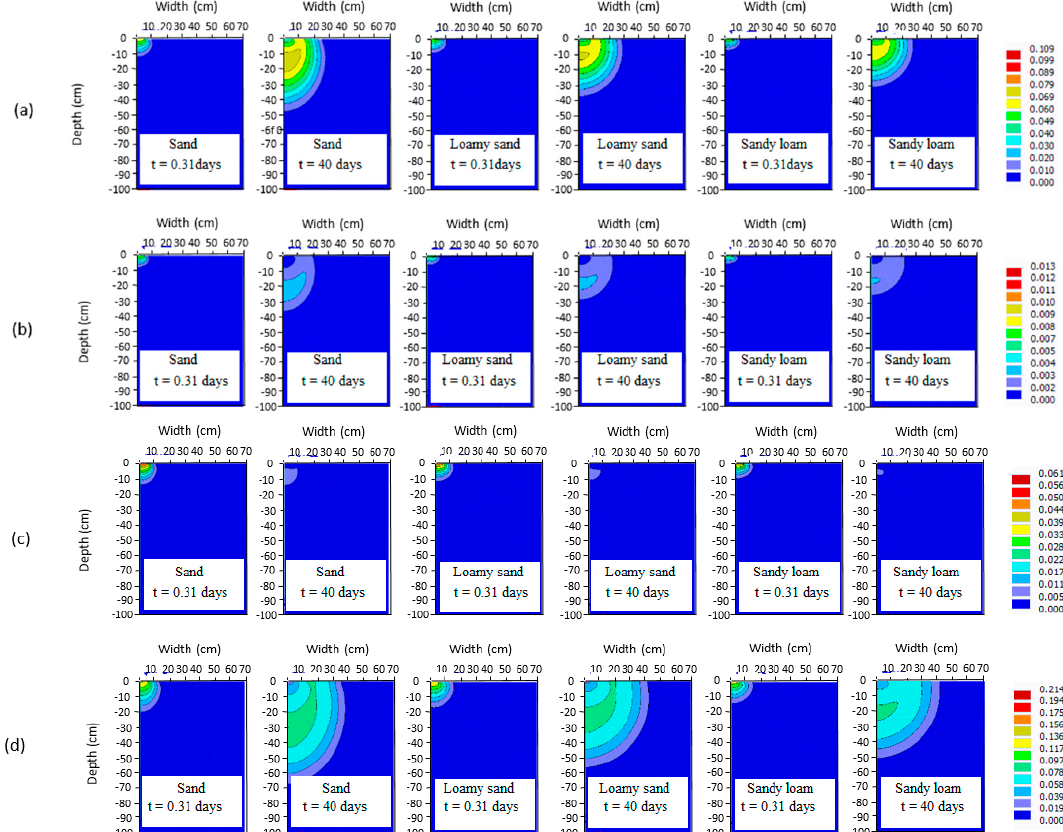
Figure 3. Fertilizer distribution after the first fertigation event ( t = 0.31 days) and at the end of simulation